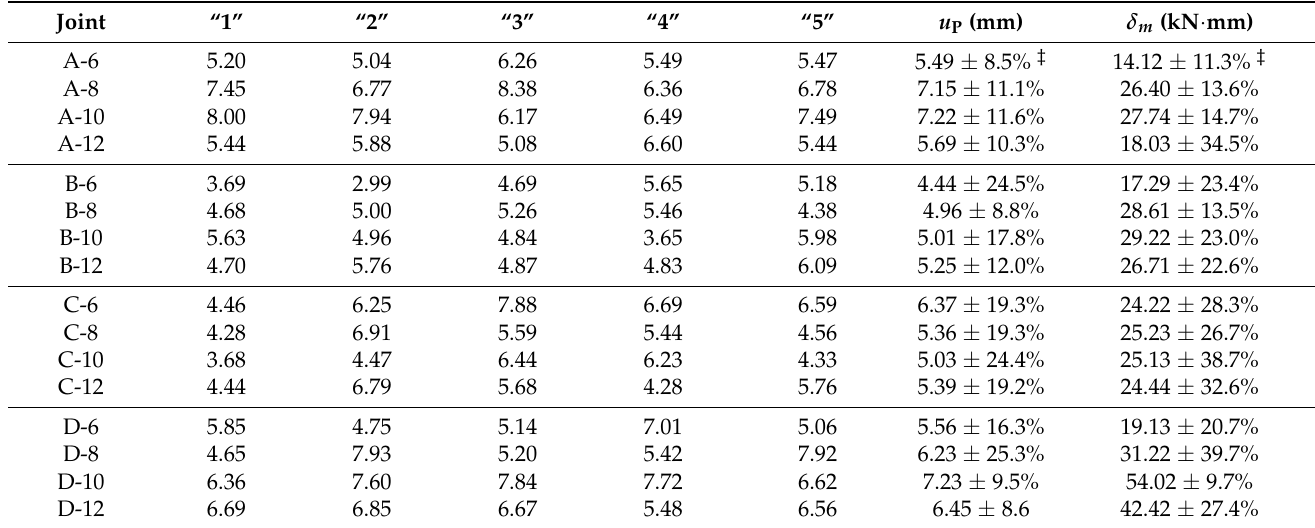
Table 6. The displacement corresponding to the ultimate load and deformation